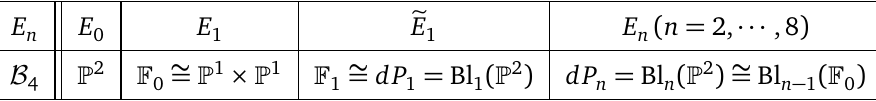
SCFTs and del Pezzo surfaces. Here, Bl n at k generic points. Note that dP 4 . 1 ( n = 2, ··· ,8 ) E E n 1